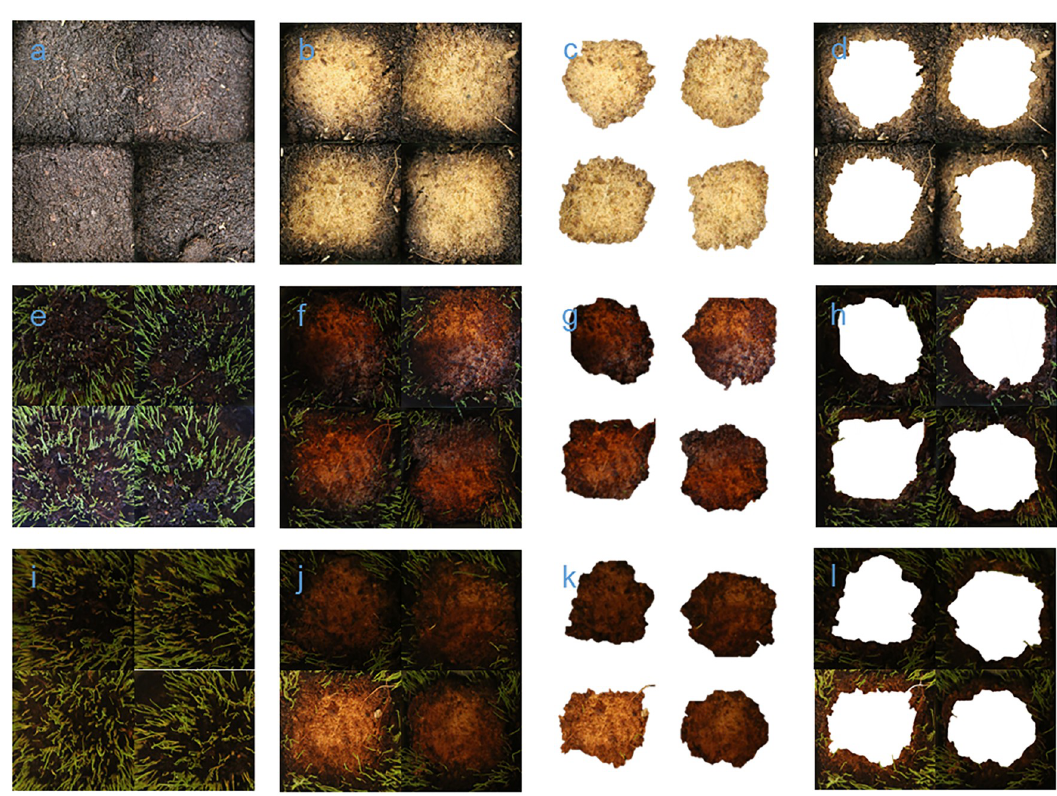
Fig 2. The pictures of 2, 4, and 5 DAT. a, b, c, and d: 2 DAT; e, f, g, and h: 4 DAT; i, j, k, and l: 5 DAT. a, e, and i: Control; b, f, and j: HP treatment (before segmentation); c, g, and k: Area directly affected by HP (P1; after segmentation); d, h, and l: Area not directly affected by HP (P0; after